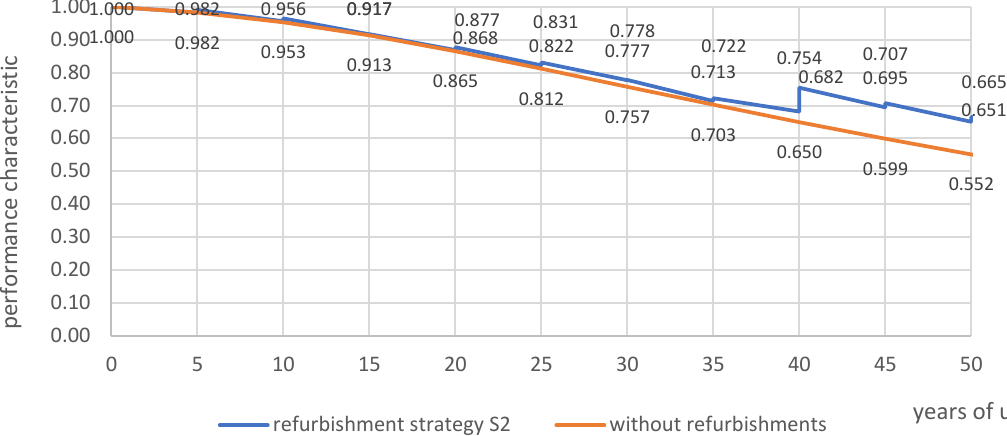
Figure 2. Prediction of changes in technical condition of a building refurbished according to S2 strategy and a building without refurbishment.